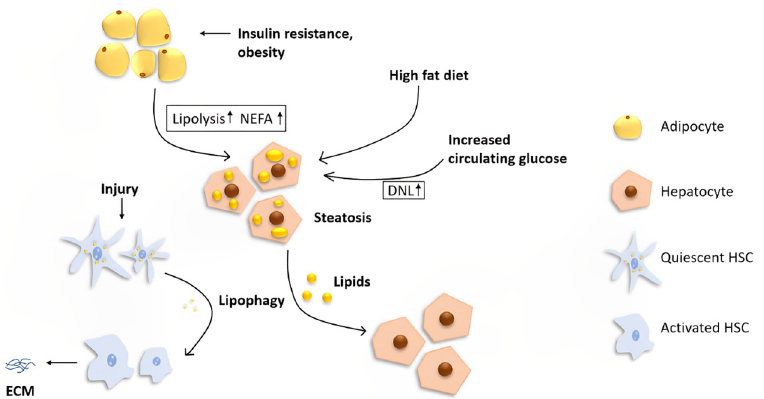
Figure 1. The role of lipophagy in the liver. Fat stored in the liver originates from three main sources: diet, DNL, and lipolysis from adipose tissues. A high-fat diet and increased circulating glucose cause increased lipid uptake and DNL, respectively. Insulin resistance and obesity lead to an increased level of lipolysis in adipocytes, resulting in a higher NEFA concentration in the systemic circulation. Increased uptake of lipids in hepatocytes leads to hepatic steatosis, which is the initial stage of NAFLD. Lipophagy plays different roles in different cells in the liver. In hepatocytes, lipophagy alleviates steatosis, while in quiescent HSCs, degradation of lipids via autophagy may fuel the cells for activation, resulting in increased extracellular matrix production and, ultimately, liver fibrosis.